Question: Write a single sentence explaining what this figure depicts.
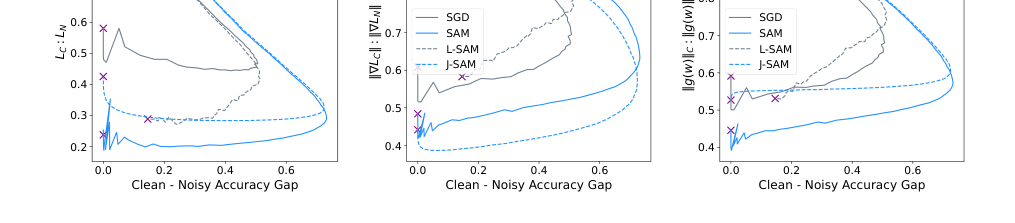
Answer: We plot the clean/noisy ratio of the loss, sample-wise gradient norm, and logit scale norm versus the clean-noisy accuracy gap. The ratios are higher with SAM and J-SAM than SGD and L-SAM for the same accuracy gap. Orange marker denotes the beginning of the training trajectory and purple denotes the end.